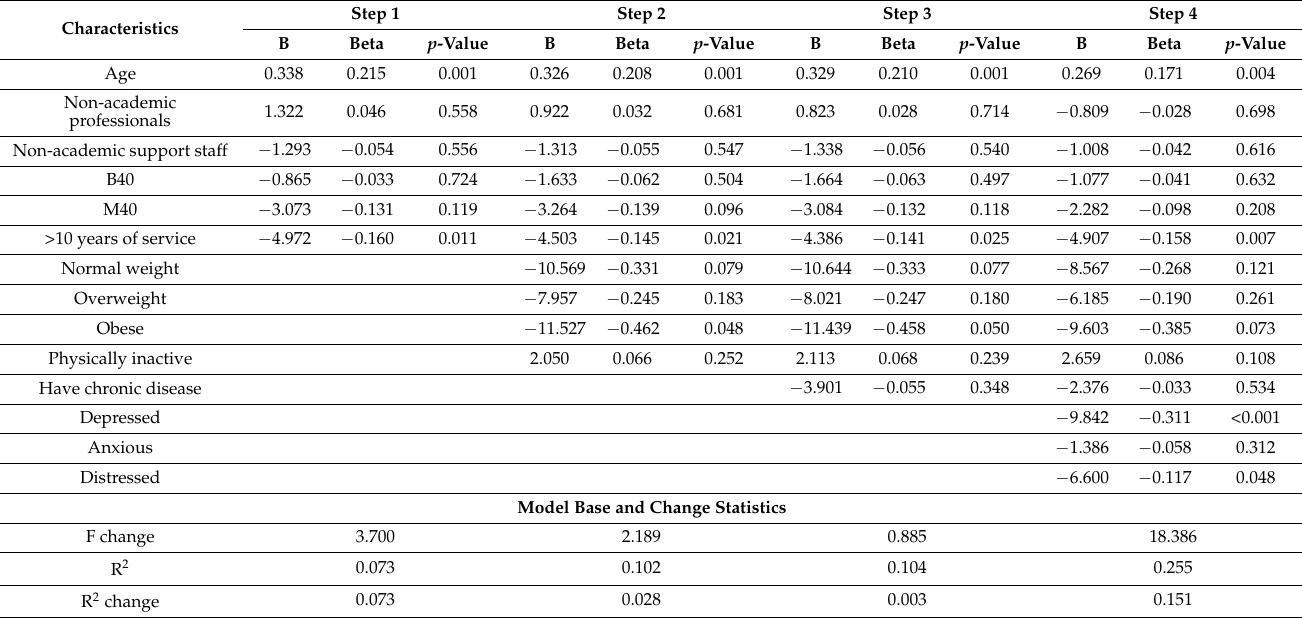
Table 5. Factors associated with psychological HRQoL according to the hierarchical multiple linear regression analysis.